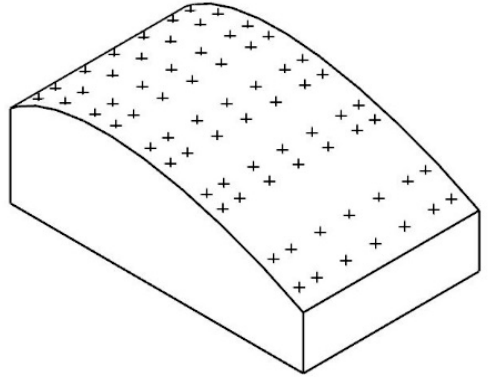
Figure 5. Illustration of the measurement points on Surface one.